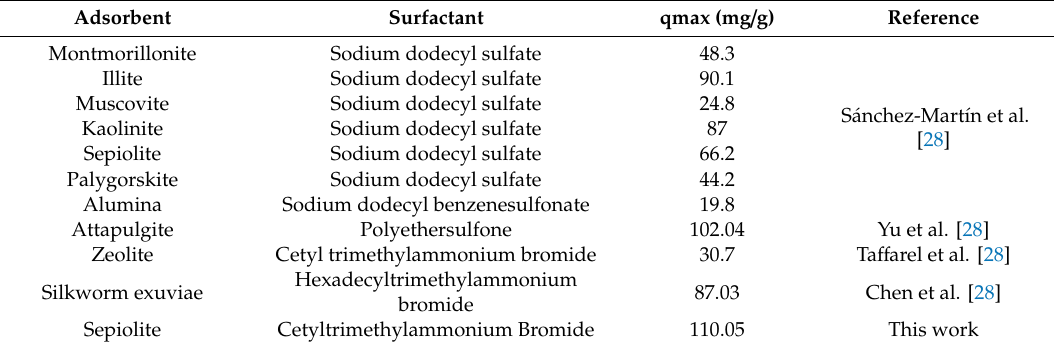
Table 4. Maximum Adsorption Capacity Comparison of Surfactant Adsorbent.